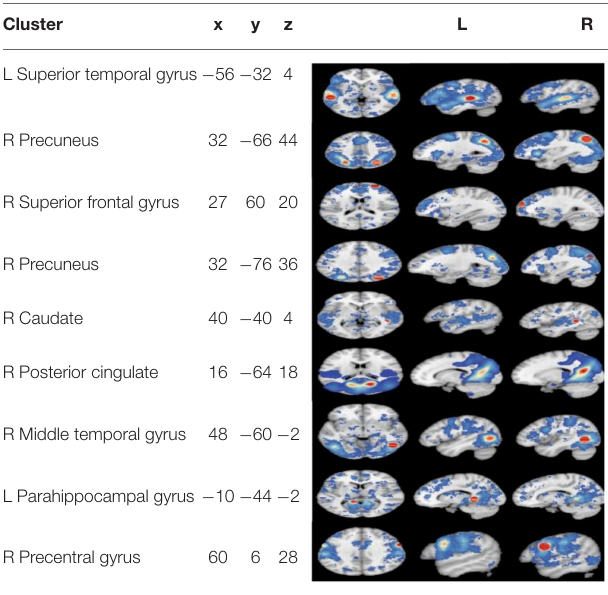
TABLE 5 | The results of co-activation